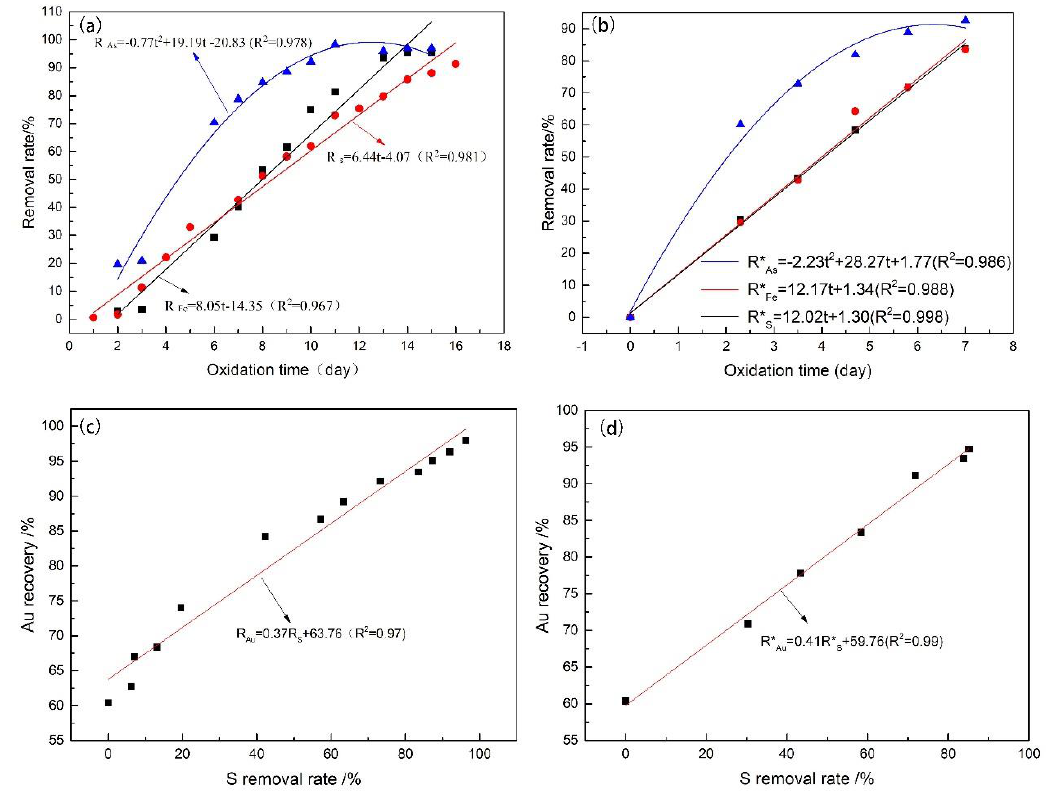
Figure 4. S, Fe, As removal rate and gold recovery: ( a ) S, Fe, As removal rate by batch bio-oxidation, ( b ) S, Fe, As removal rate by continuous bio-oxidation, ( c ) relationship of gold recovery and sulfur removal rate by batch bio-oxidation, ( d ) relationship of gold recovery and sulfur removal rate by continuous bio-oxidation.